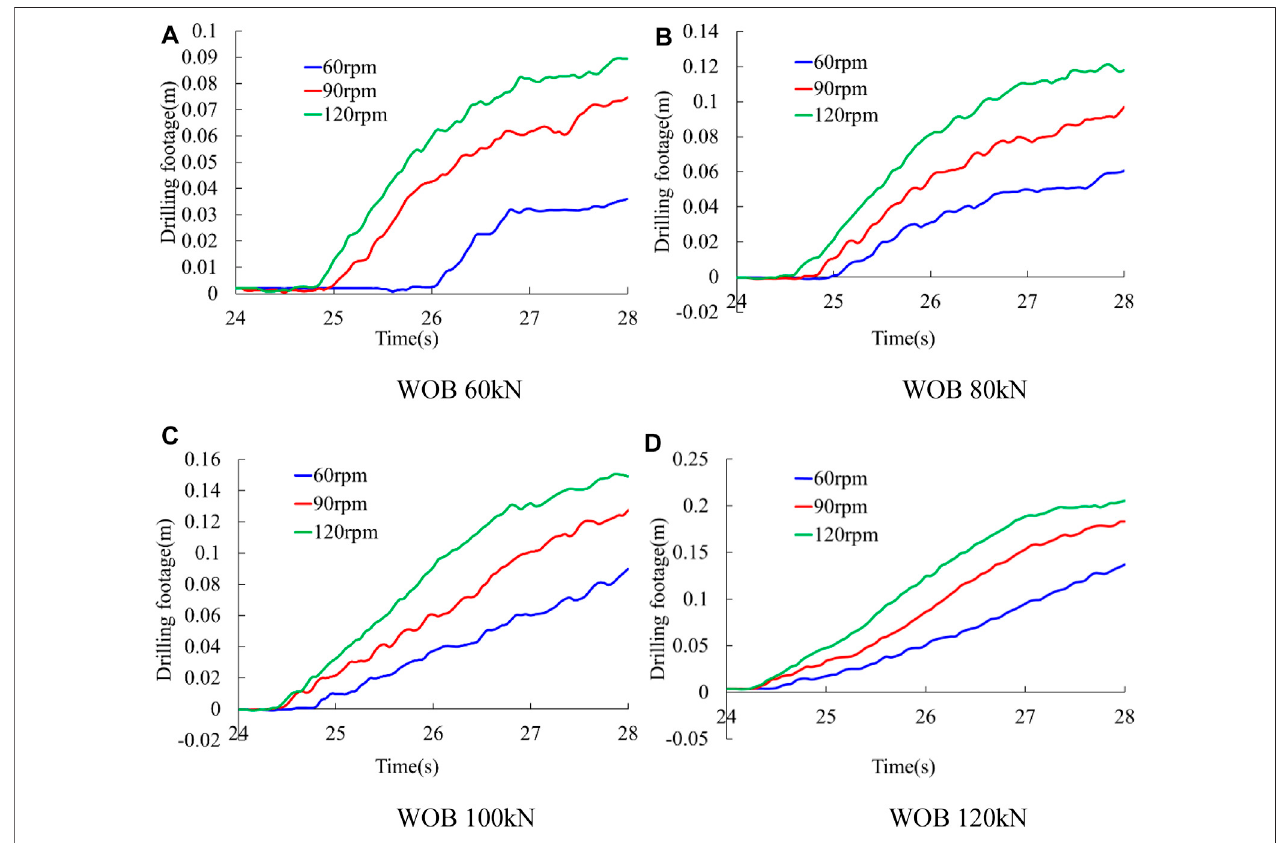
FIGURE 11 | Drilling footage of drill